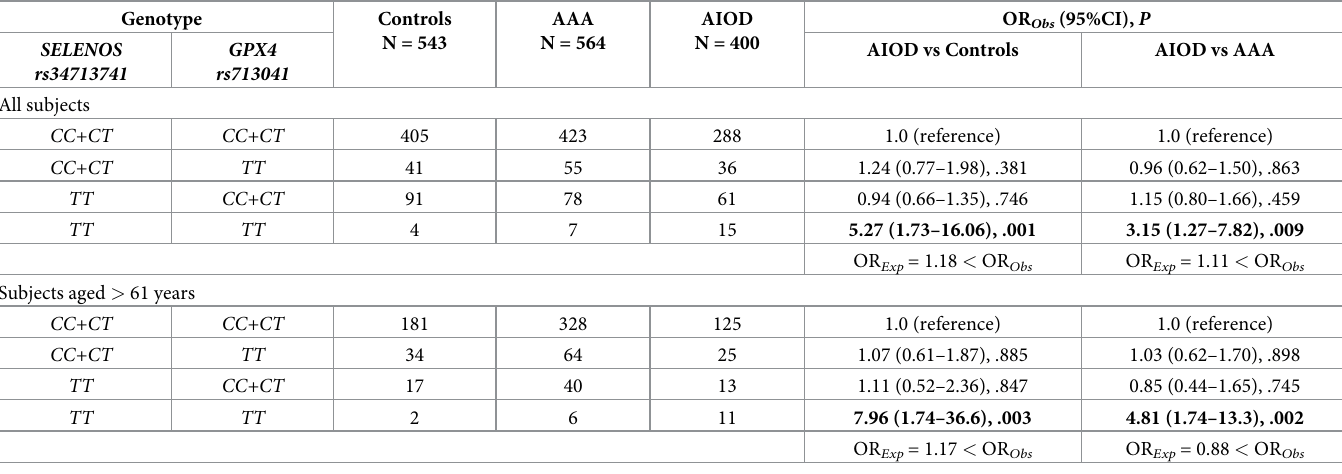
AAA , abdominal aortic aneurysm; OR Exp , odds ratio expected from additive model; OR Obs , odds ratio